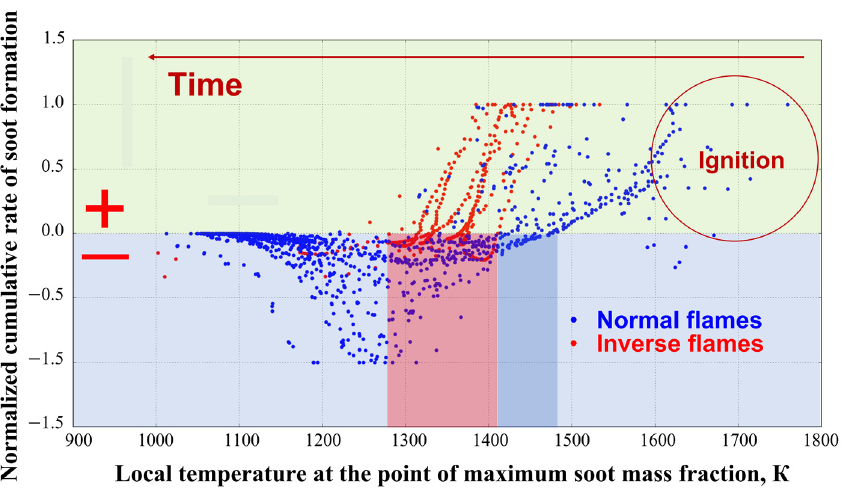
Figure 9. The normalized cumulative rate of soot formation 𝑚 (cid:3046)(cid:3042)(cid:3042)(cid:3047),(cid:2954) (𝑡)(cid:4662) in normal and inverse flames listed in Tables 2 and 3 as a function of the instantaneous local gas temperature at the point of maximum soot mass fraction in the flame structure.